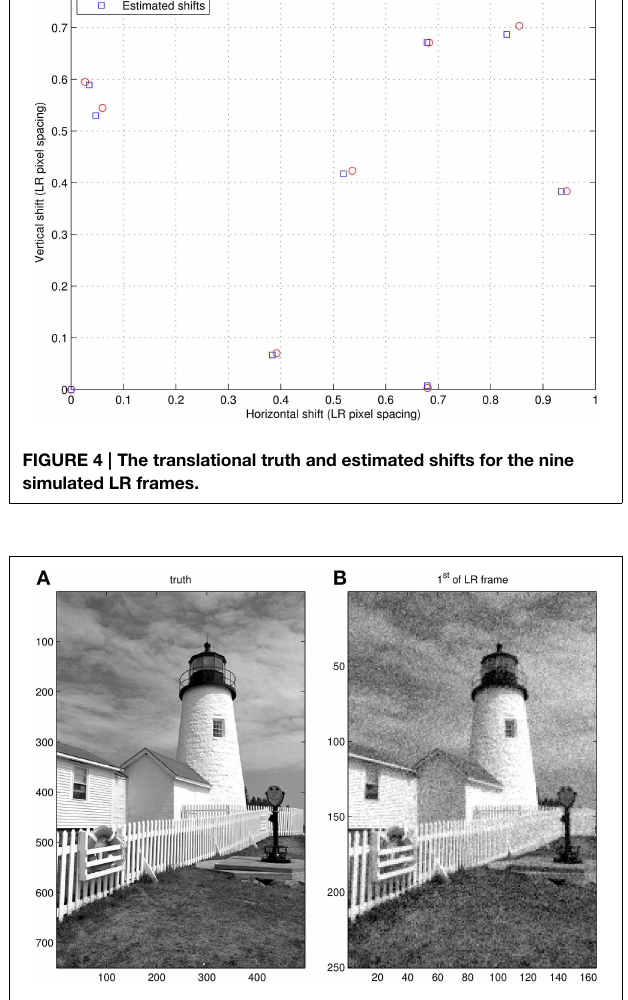
3 , P 9 , and σ η 10 = = =